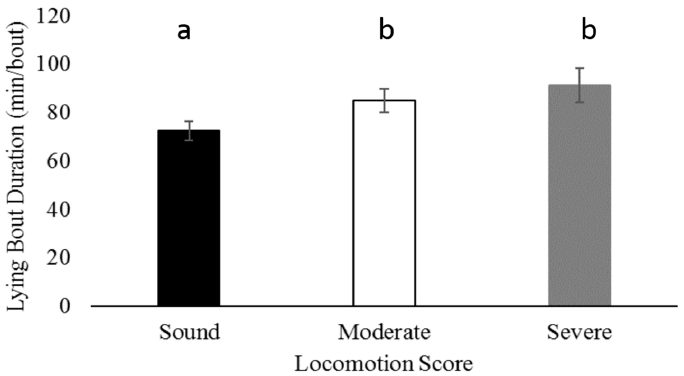
Figure 2. Sound cows (locomotion score = 1) had shorter mean lying bout duration compared to moderately lame cows (locomotion score = 2; p = 0.004) and severely lame cows (locomotion score = 3; p = 0.01). Differences between sound, moderately lame, and severely lame cows are designated by superscripts “a” and “b.”